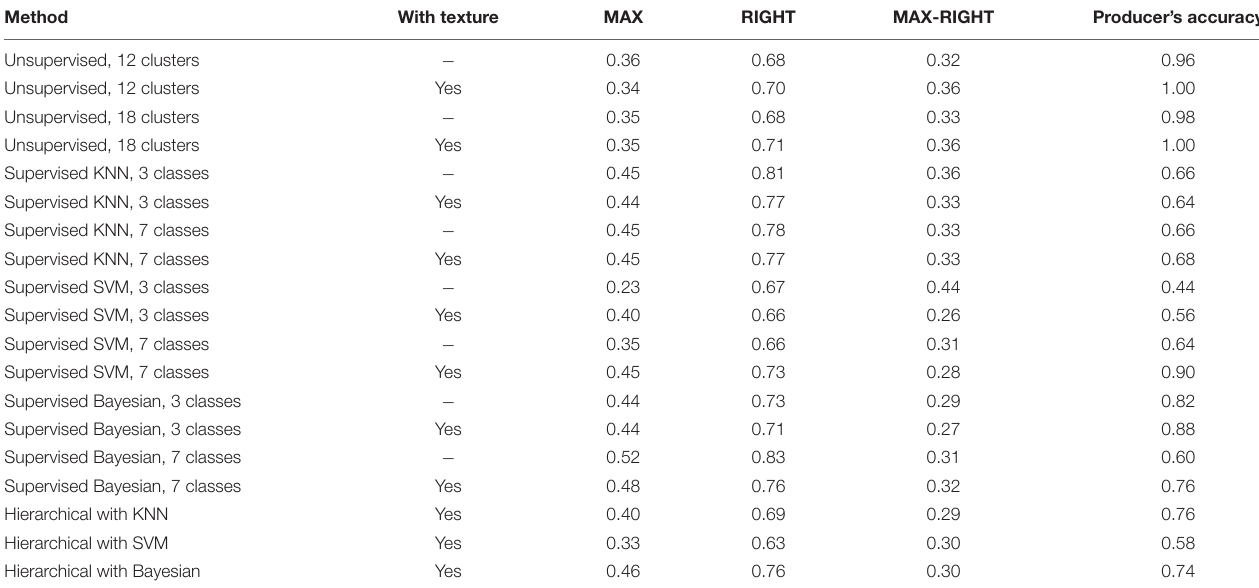
FIGURE 4 | Distribution of medusahead patch segment lengths in the field transects (left) and counts of medusahead segments in four major length categories (right). TABLE 1 | Fuzzy accuracy metrics for medusahead classification by different methods (MAX and RIGHT metrics denote the proportions of test samples classified as medusahead having medusahead as the best and acceptable class, respectively; Producer’s accuracy metric indicates the proportion of test samples with medusahead as the best class which included classified